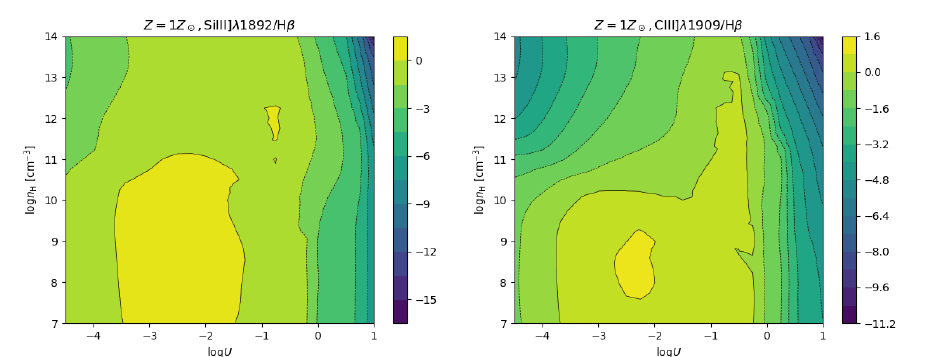
Figure 3. The decimal logarithm of the ratio between intercombination emission lines and H β as a function of ionization parameter U and hydrogen density n H , as in the previous figures. Left: Si III ]/H β ; right: C III ]/H β .